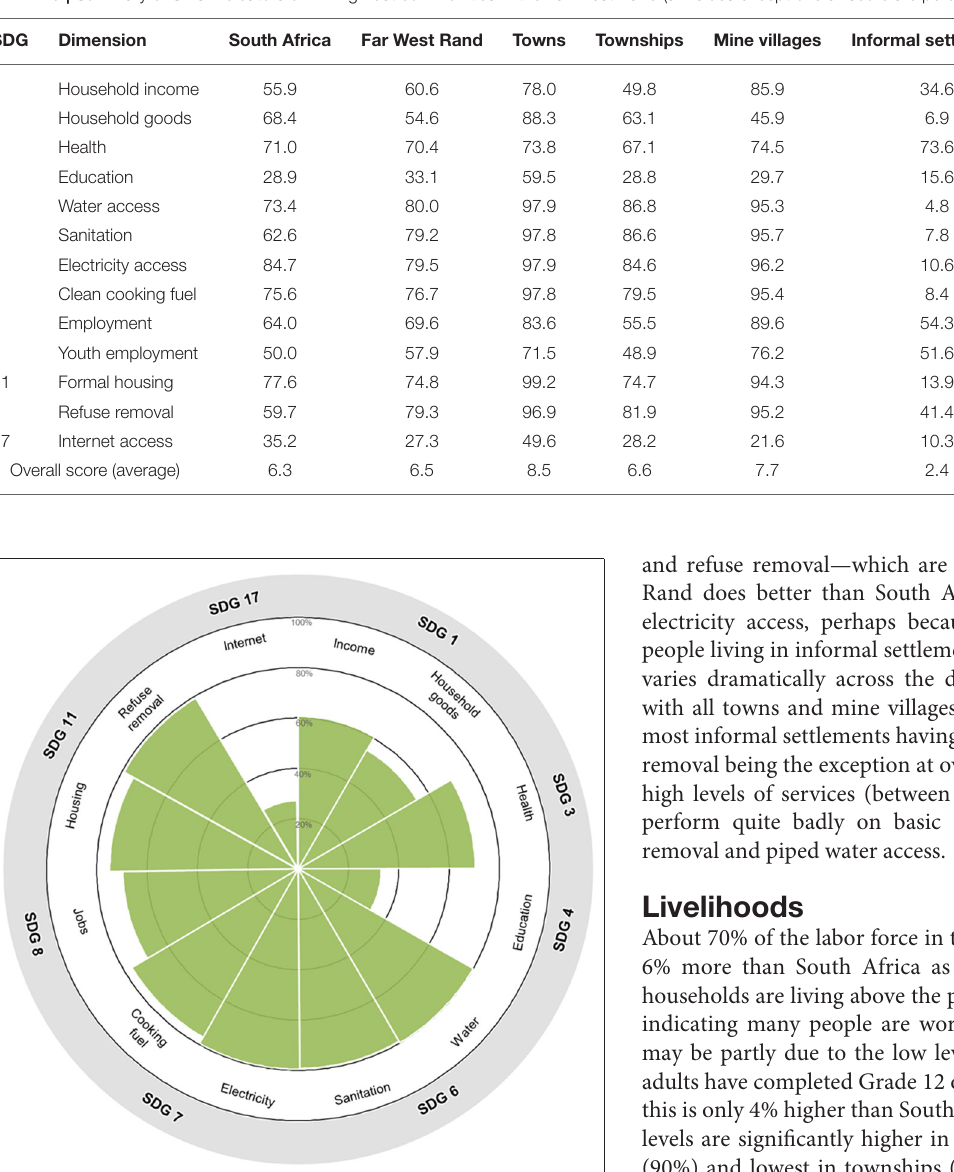
TABLE 5 | Summary of SDG indicators of mining host communities in the Far West Rand (all values except overall score are percentages).